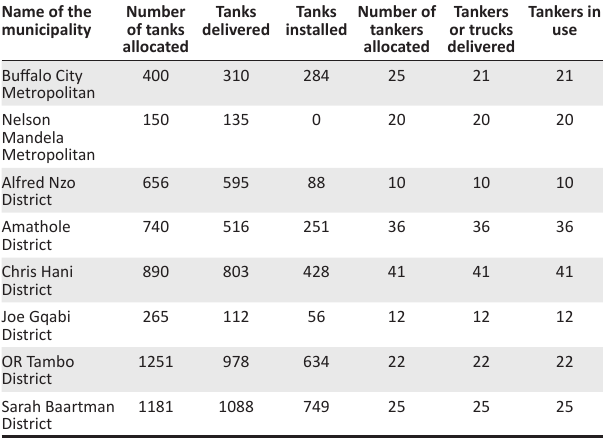
TABLE 1: Eastern Cape intervention as of 15 June